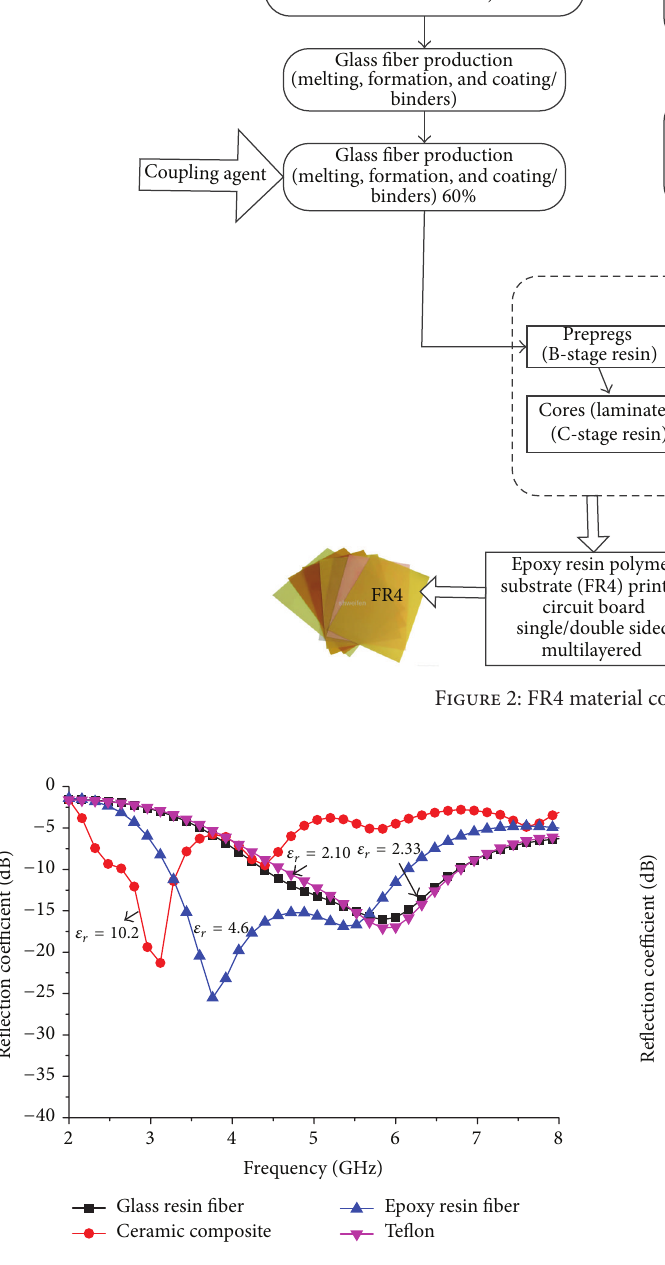
Figure 3: Effect of reflection coefficient for four different dielectric materials. Figure 4: Effect of reflection coefficient for different slot